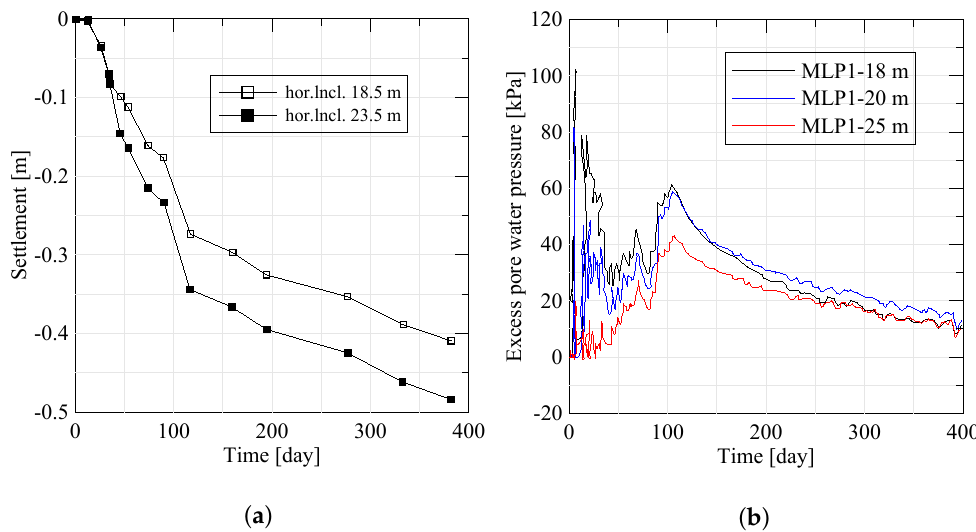
Figure 7. Field measurement in Klagenfurt Project. ( a ) vertical displacements at surface; ( b ) excess pore water